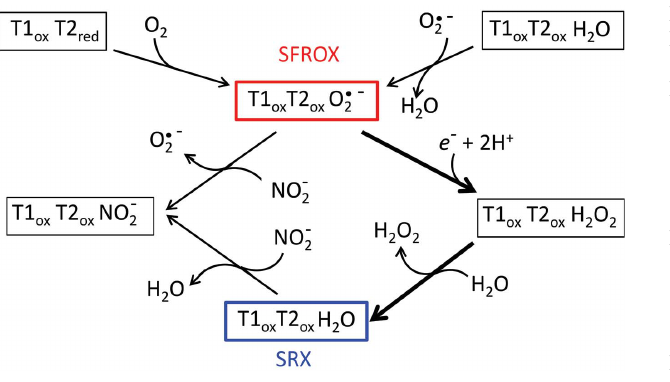
Figure 6 A simplified reaction scheme for the binding of dioxygen and nitrite to Ax NiR based on structural characterization. The superoxide species characterized by SF-ROX is stable unless a second electron is supplied. It could be arrived from two possible